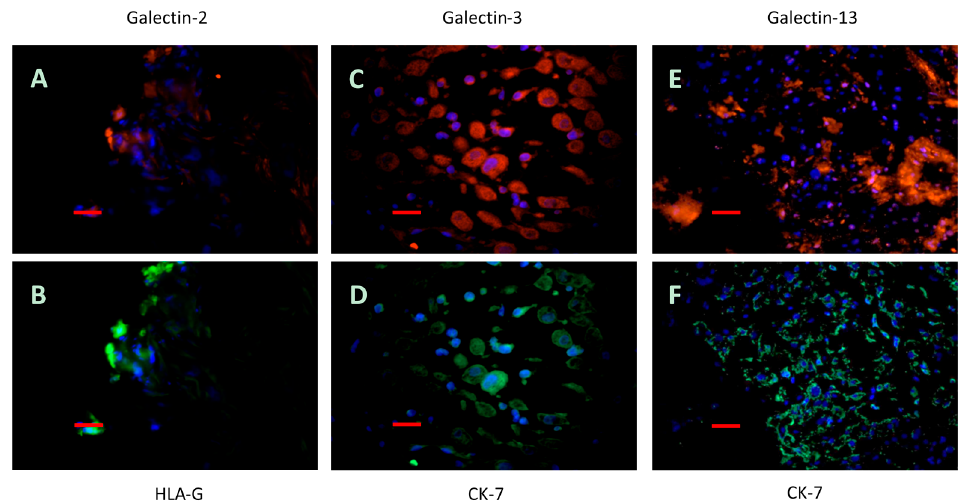
Figure 7. Gal-2 ( A ) (marked in red color) was found exclusively expressed by extravillous trophoblast cells marked with an HLA-G antibody ( B ); marked in green. A similar expression schema was found for gal-3 in the decidua. Gal-3 ( C ); also with red staining, showed a strong co-expression with CK-7 ( D ); shown in green. In addition, gal-3 is also expressed by cells negative for CK-7. Gal-13 staining in red ( E ) was found co-expressed by extravillous trophoblast cells marked with a CK-7 antibody in green ( F ). Scale bar, 500 µm in all cases.